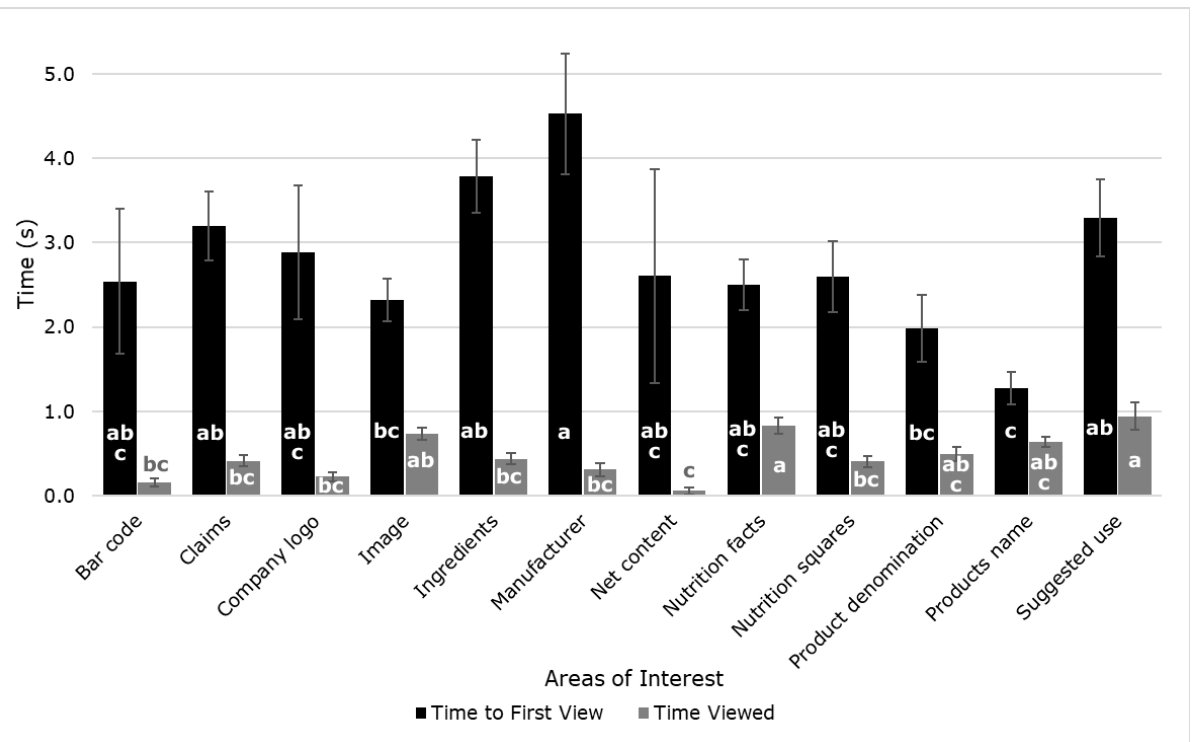
Figure 4. Mean values of the time to first view and time viewed from the eye-tracking analysis of the labels evaluated. Error bars represent the standard error. Different letters denote significant differences based on the ANOVA and Tukey honest significant difference (HSD) post hoc test ( α = 0.05).